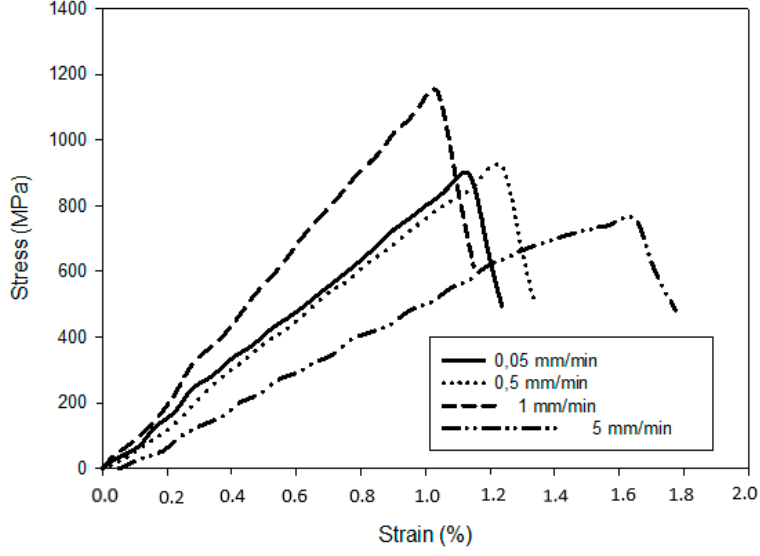
Figure 2. Tensile stress–strain curves for the four cross-head speeds at gage length 10 Figure 2: Tensile stress–strain curves for the four cross-head speeds at gage length 10 mm.